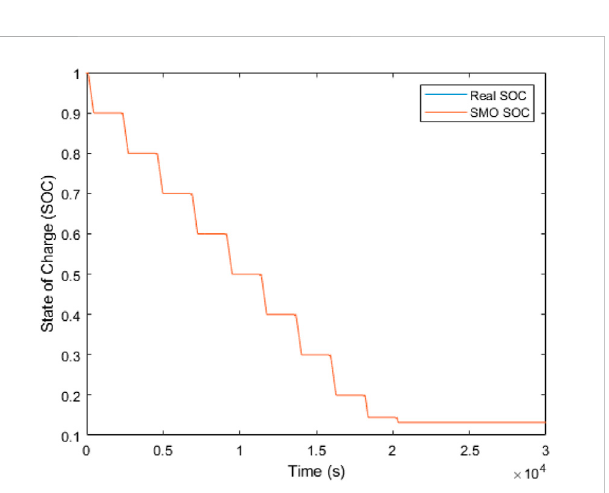
FIGURE 5 Model response of the fi rst-order ECM.